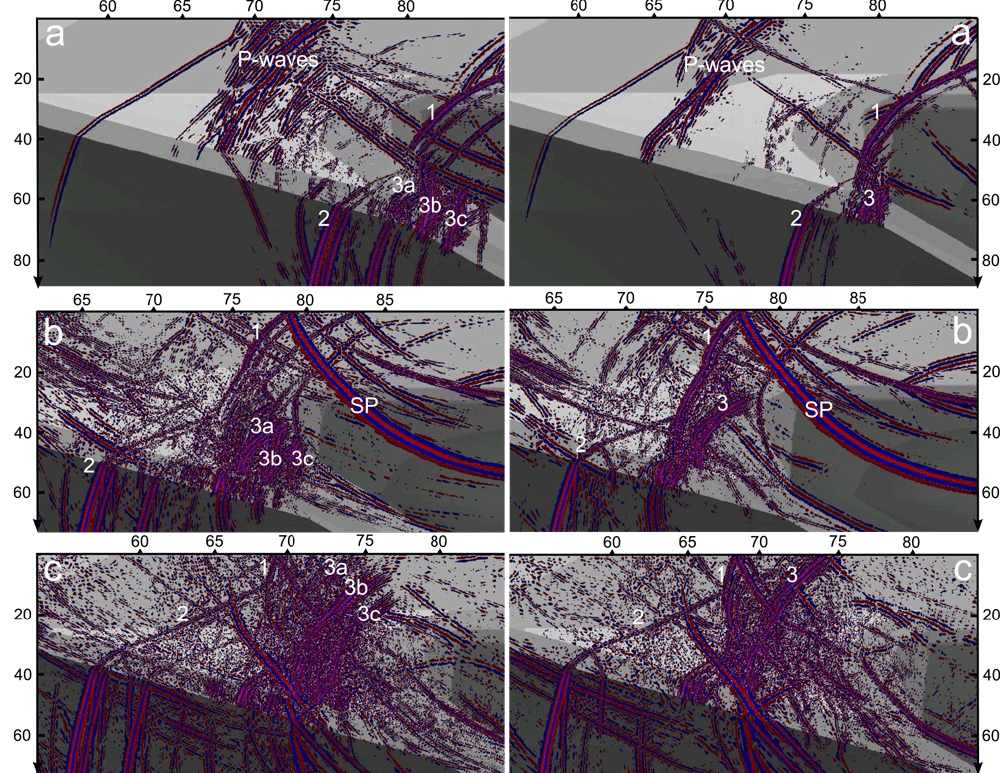
Fig. 14: Sequence of snapshots of vertical displacement for double couple source. Left panels: model with DSC. Right panels: model without DSC. Vertical axis annotation gives depth in km. Horizontal axis specifies index of receivers. Phase identification is given in Fig. 13. (a) t = 24 . 75 s. Guided S waves about to enter the serpentinized mantle wedge; several wave packets have developed in model with DSC (phases 3a, 3b, 3c). (b) t = 34 . 1 s. Guided wave already in serpentinized area, direct S wave already at surface, note strong SP surface conversion. (c) t = 44 s. Guided waves about to reach the surface. See Fig. 6 for explanation of axis labels and color